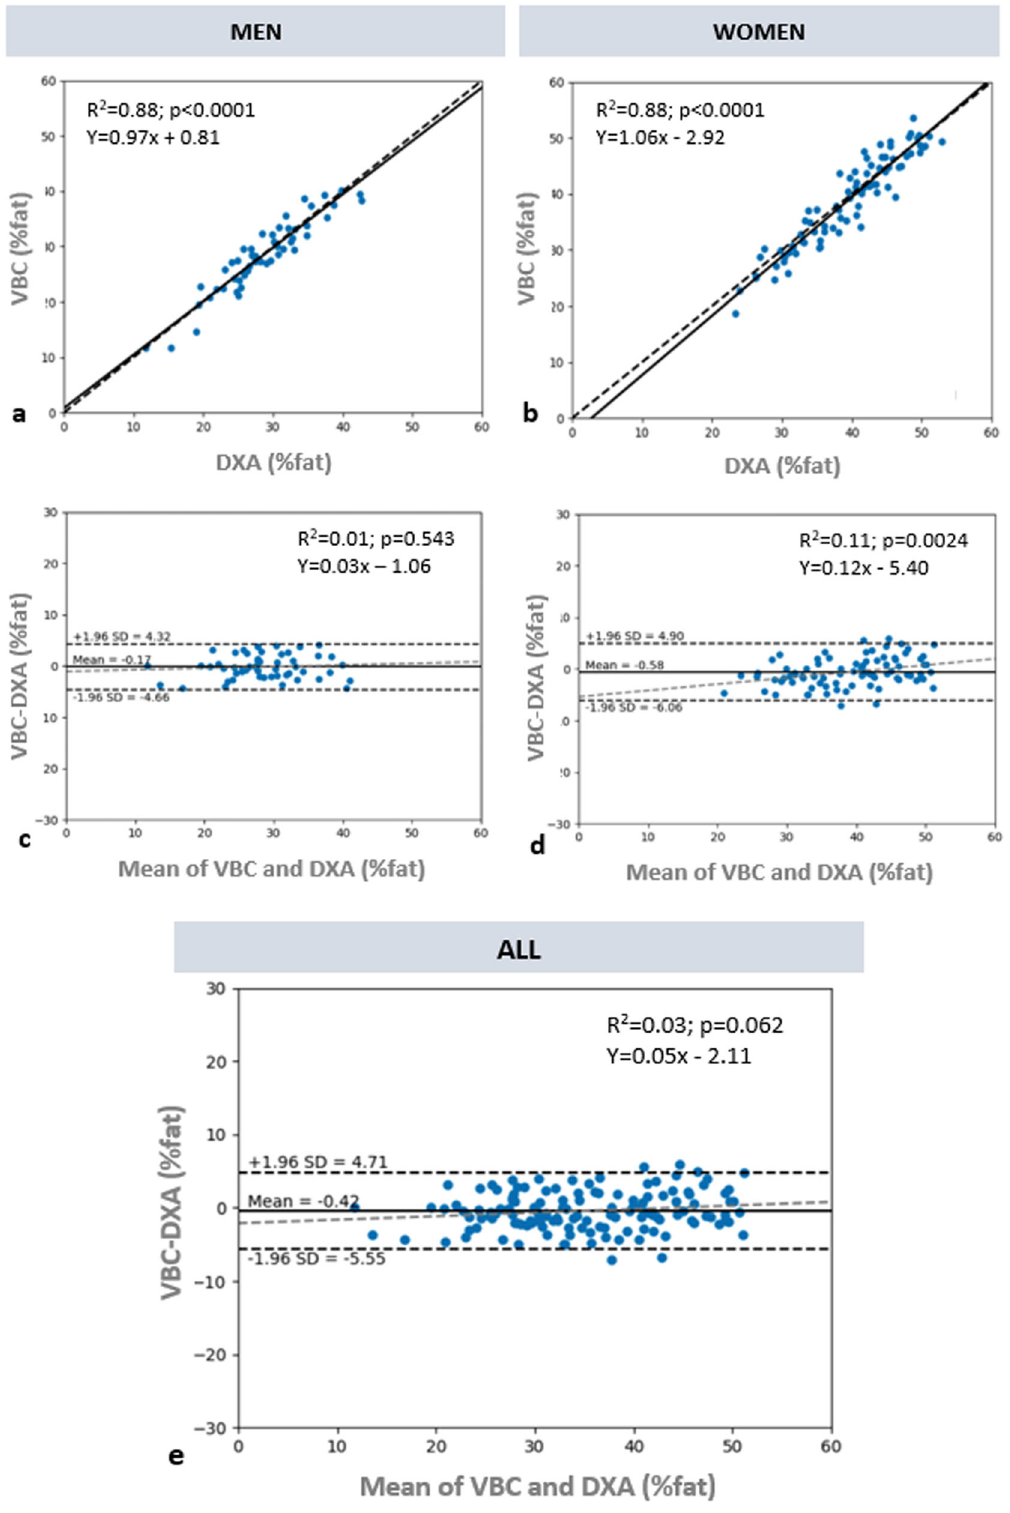
Fig. 3 Comparison of %BF between VBC and DXA. Correlation between %BF by VBC and DXA, for a men and b women. The dashed line is identity and the solid line is the automatically fi tted regression line. The two lines are very close to one another, and the correlations in both fi gures are signi fi cant at p < 0.0001. Bland-Altman analysis of the difference between %BF by VBC and DXA, for c men, d women, and e all. The horizontal black lines are at the mean ± 1.96 SD and the dashed gray lines are the fi tted regression lines described by the equation in the